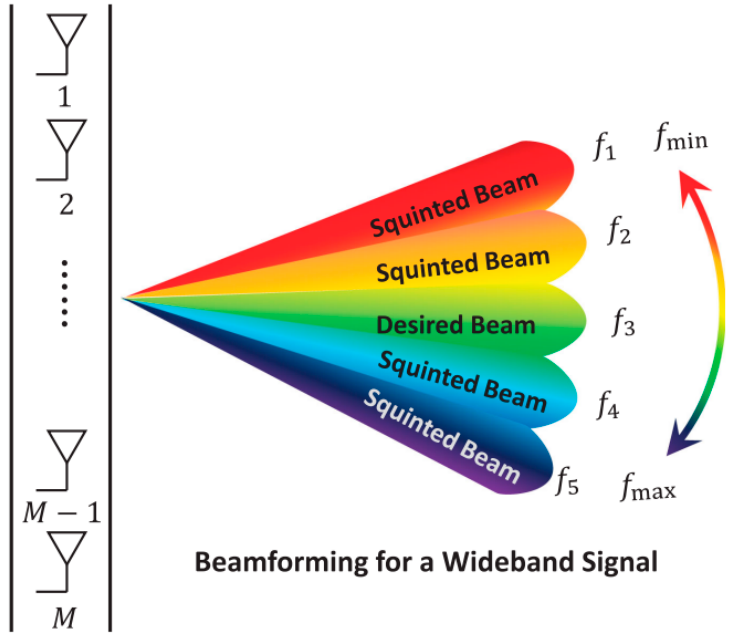
Figure 5. The effect of beam squint [9].